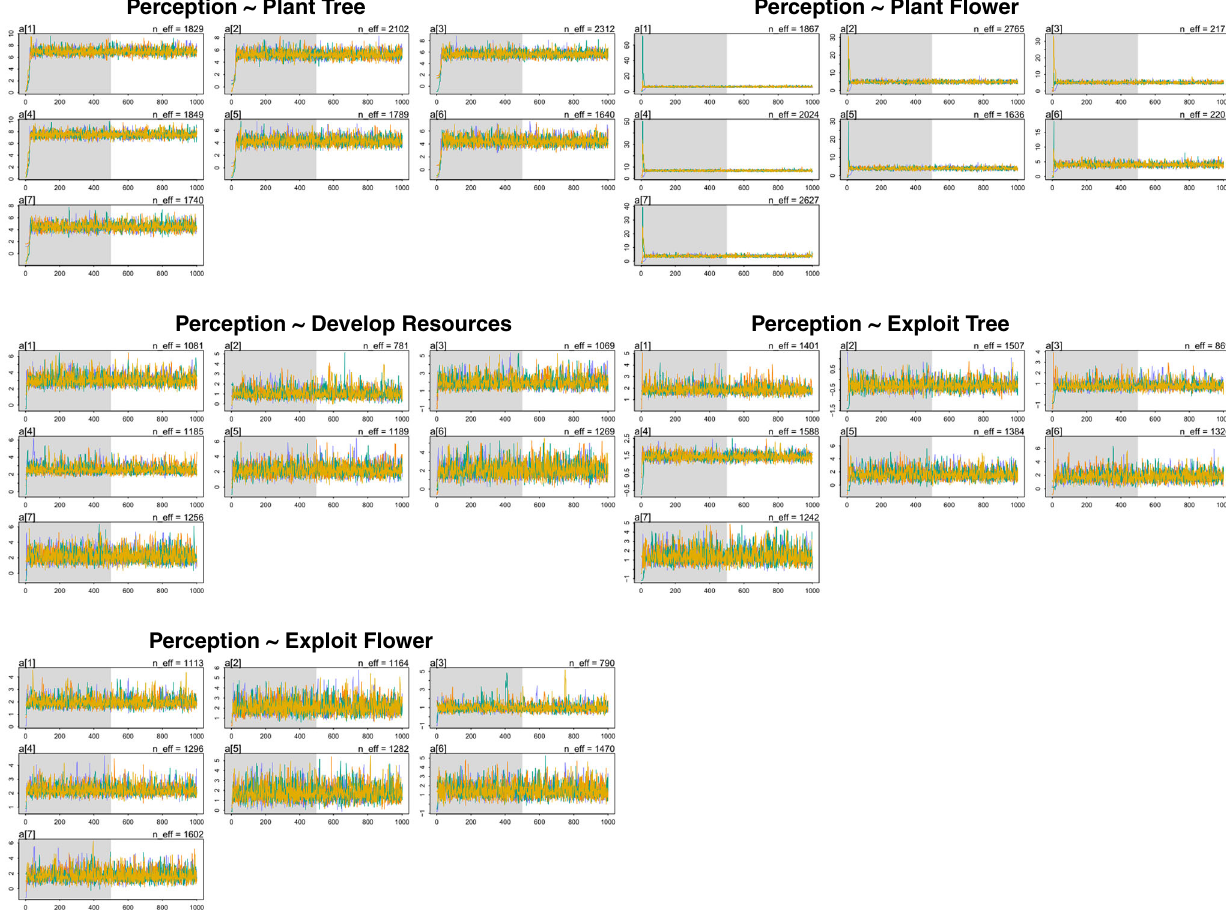
Fig. 1 The trace plots for the models. Note: Asian = 1, Black or African American = 2, Hispanic or Latino = 3, Caucasian = 4, Native American or American Indian = 5, Paci fi c Islander = 6, Other =